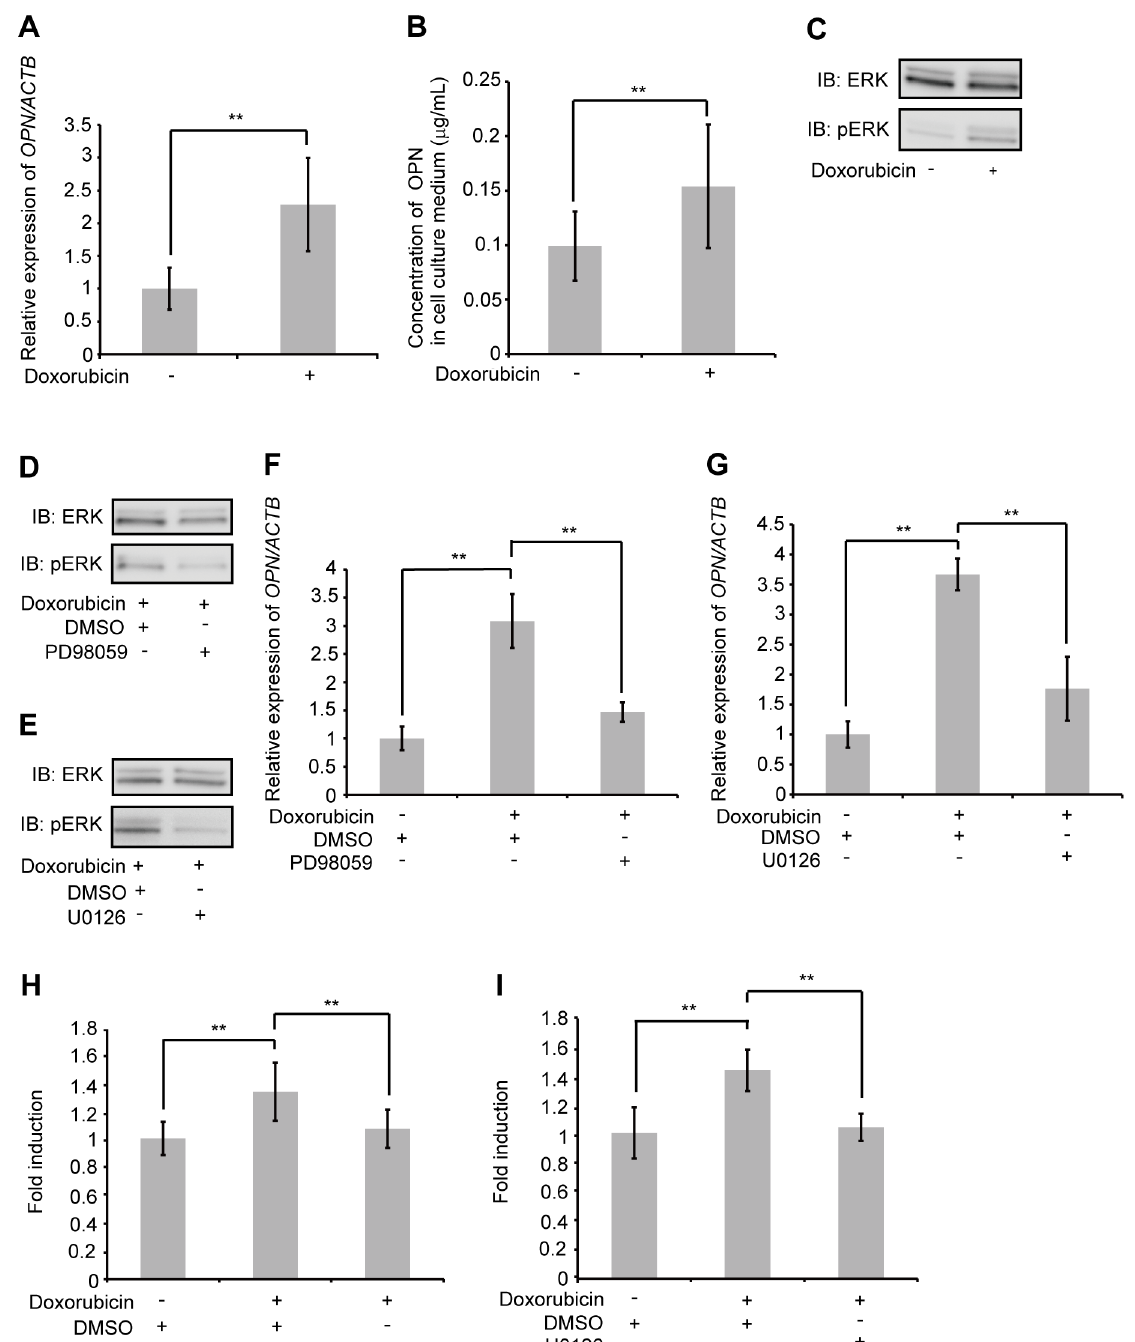
Figure 3. Effect of doxorubicin on OPN expression and molecular mechanism of OPN induction. (A and B) A549 were exposed to 50 nM doxorubicin or PBS for 48 h. (A) OPN mRNA was assessed by qRT-PCR. (B) OPN concentrations in cell culture media were determined by ELISA. (C) A549 were exposed to 50 nM doxorubicin or PBS for 24 h. Western blotting was used to detect phospho-specific ERK1/2 and ERK1/2. (D) A549 were pretreated with PD98059 (50 m M) or DMSO for 1 h, and subsequently exposed to 50 nM doxorubicin for 48 h. Western blotting was used to detect phospho-specific ERK1/2 and ERK1/2. (E) A549 were pretreated with U0126 (50 m M) or DMSO for 1 h, and subsequently exposed to 50 nM doxorubicin for 48 h. Western blotting was used to detect phospho-specific ERK1/2 and ERK1/2. (F) A549 were pretreated with PD98059 (50 m M) or DMSO for 1 h, and subsequently exposed to 50 nM doxorubicin or PBS for 48 h. OPN mRNA was assessed by qRT-PCR. (G) A549 were pretreated with U0126 (50 m M) or DMSO for 1 h, and subsequently exposed to 50 nM doxorubicin or PBS for 48 h. OPN mRNA was assessed by qRT-PCR. (H) A549 were pretreated with PD98059 (50 m M) or DMSO for 1 h, and subsequently exposed to 50 nM doxorubicin or PBS for 48 h. OPN concentrations in cell culture media were determined by ELISA. (I) A549 were pretreated with U0126 (50 m M) or DMSO for 1 h, and subsequently exposed to 50 nM doxorubicin or PBS for 48 h. OPN concentrations in cell culture media were determined by ELISA. Data are presented as mean 6 S.E. *, P , 0.05; **, P , 0.01.